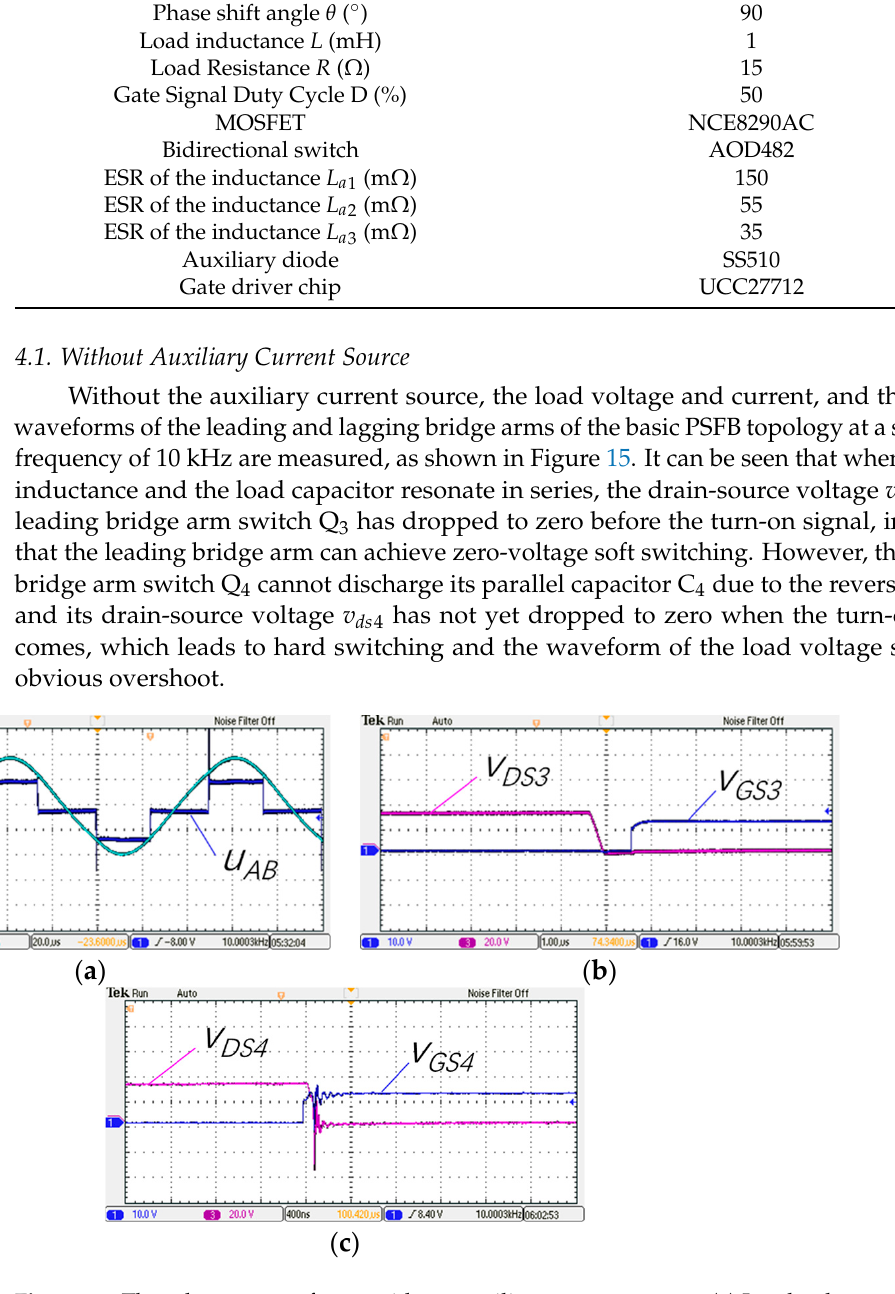
( d ) Figure 16. The relevant waveforms with auxiliary current source. ( a ) Load voltage and current waveforms; ( b ) Injection current waveform; ( c ) Q 3 trigger signal and Q 3 drain-source voltage wave- form; ( d ) Q 4 trigger signal and Q 4 drain-source voltage waveform. It can be seen from the figure that the leading bridge arm can still achieve zero-volt- age soft switching, and the drain-source voltage v ds 4 of the switch Q 4 can be discharged when the turn-on signal comes, and is completely discharged before the turn-on signal, indicating that the lagging bridge arm can also achieve zero-voltage soft switching due to the auxiliary current source. The current stresses of the auxiliary inductance and the aux- iliary capacitor are 2.56 A, 1.52 A, which are lower than their respective current ratings of